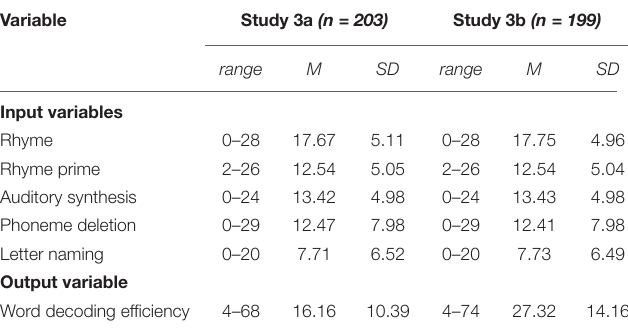
TABLE 8 | Descriptive statistics for raw scores on input variables and output variable of the model.